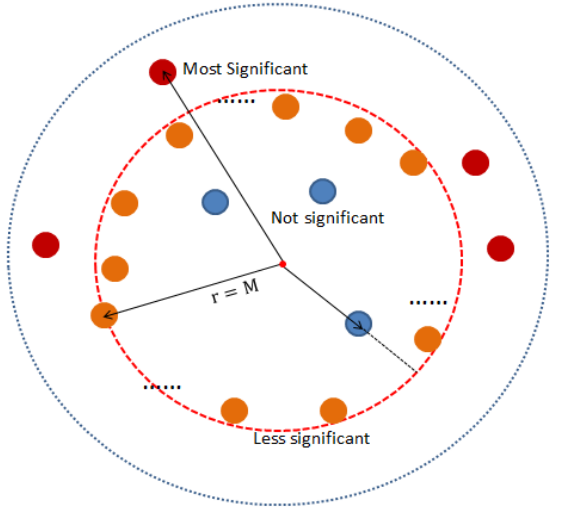
Figure 8. Illustration of Hidden Systemic